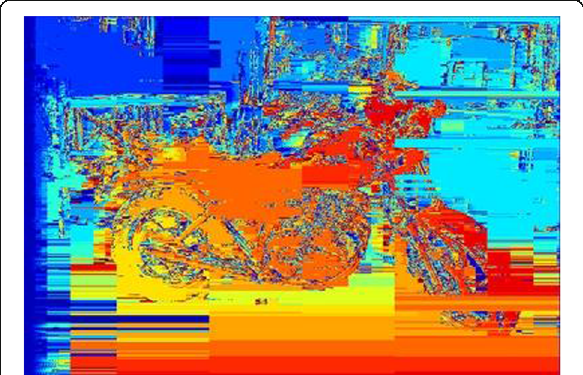
Fig. 4 Disparity image produced using the RMA method. Region- based matching nature of RMA is clearly visible in the image. RMA output contains less noisy pixels, but uniform disparity value assignment for the whole region is clearly